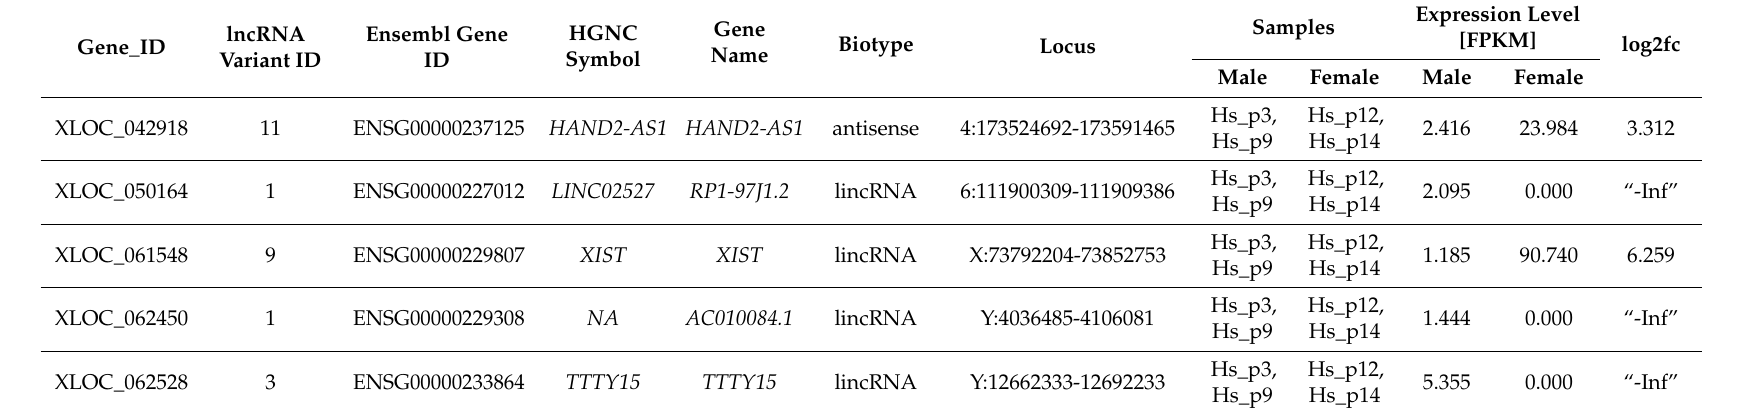
Table 2. Differences in expression level of lncRNAs in sex-bias